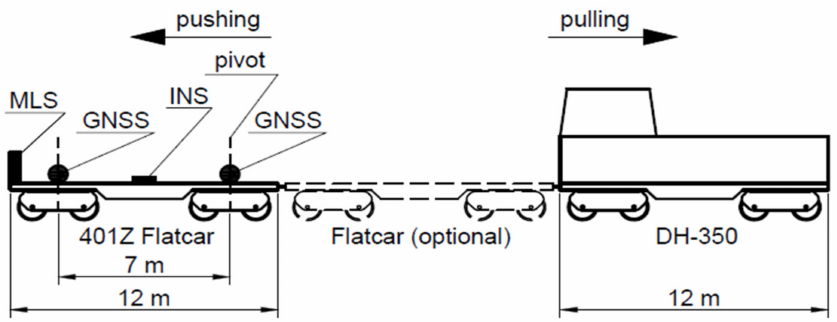
Figure 5. Configuration of the measuring unit used in Mobile Satellite Measurements.